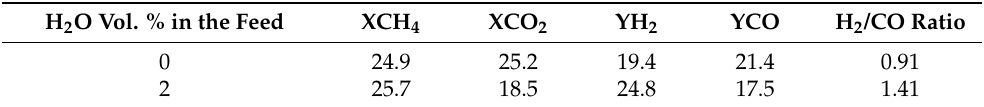
Table 6. Conversions and yields for the Ru/ZrO 2 -La 2 O 3 catalyst measured in the activity essays of the DRM carried out in a Pd MR with and without H 2 O in the feed at 450 ◦ C. H 2 O Vol. % in the